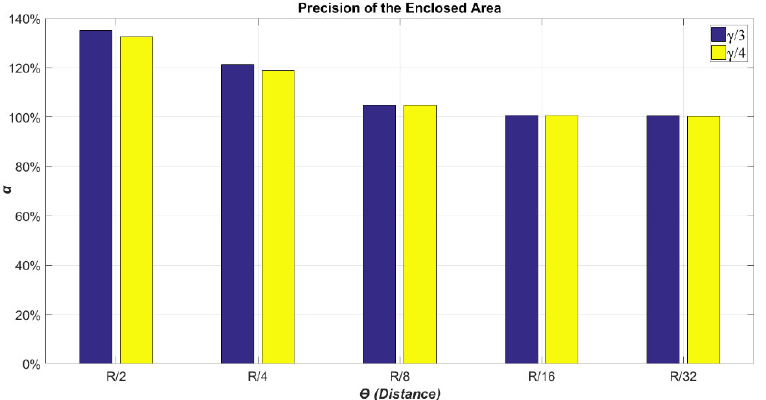
Figure 8. The Precision of the Enclosed Area with Different Terminated Thresholds. When the ter- minating threshold is small, shortening the moving step size can improve the precision, but the number of moving rounds will increase exponentially (referring to Figure 7). Setting the θ at R/8 is more suitable for compromising the computation convergence and the area precision.